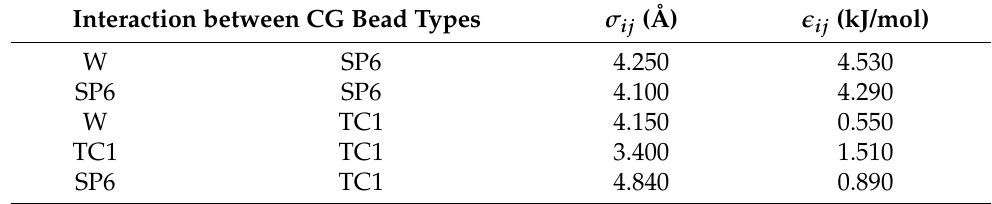
Figure 4. Time average RMSD of I α , I β , and type-II cellulose fibrils as a function of the Martini 3 bead types and three different elastic constants for O2-O6 and O3-O6 intramolecular distances. Reference snapshot for each system is the last frame from all-atom MD simulations. Some bead types are not shown in the plot as they induced large CG-MD instability during the simulation. Table 2. Optimal Martini 3 nonbonded parameters for cellulose I allomorphs (I α and I β ) and type-II. CG3 is defined by bead type TC1 and CG1, CG2 and CG4 as SP6 bead